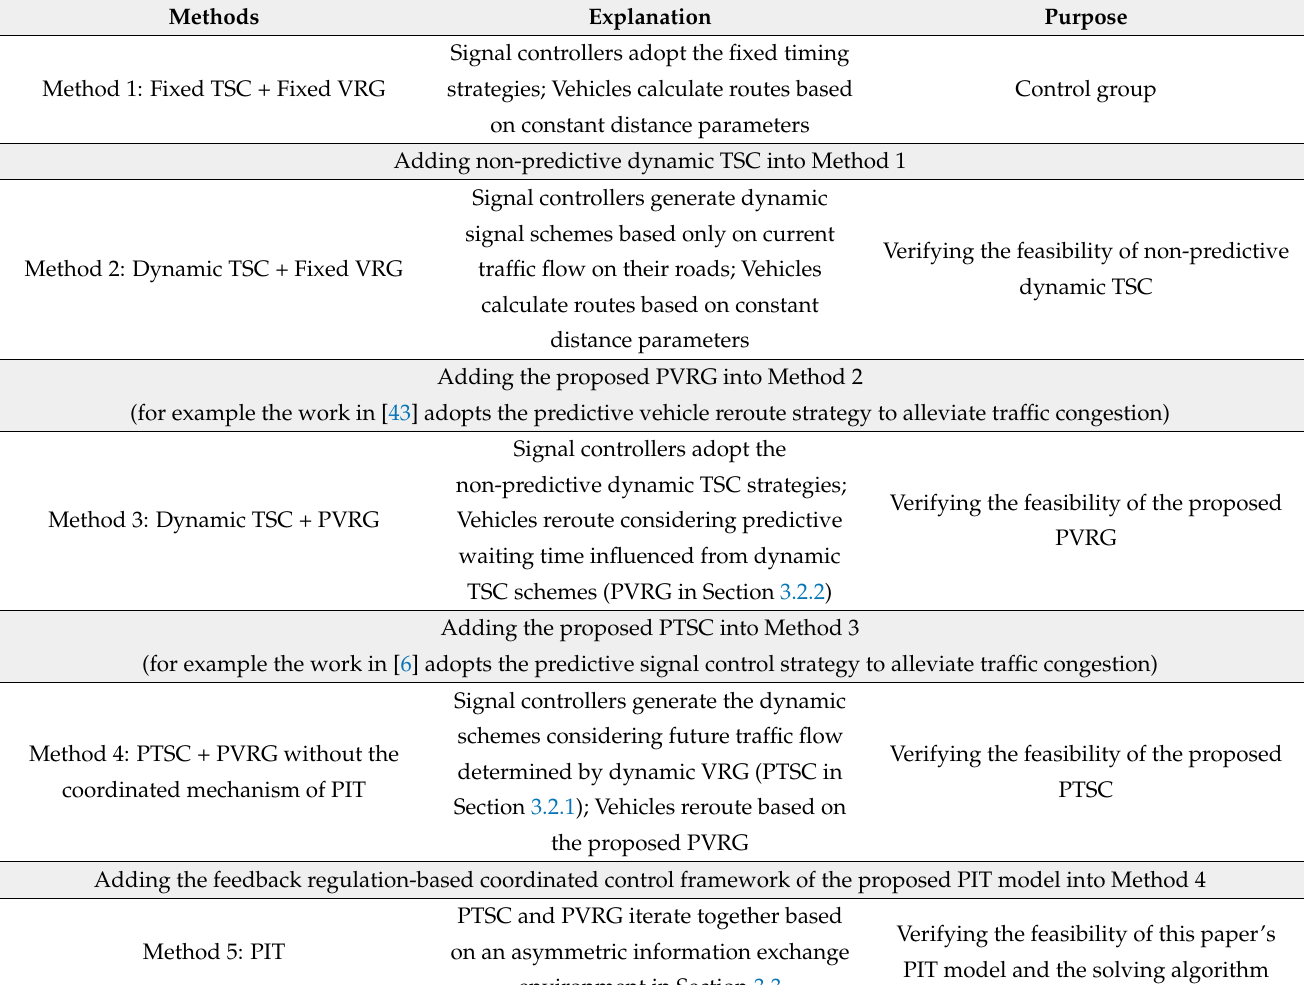
Table 1. Methods of simulation